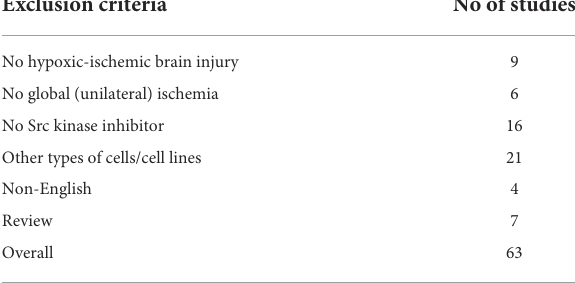
TABLE 1 Studies not eligible based upon the exclusion criteria.